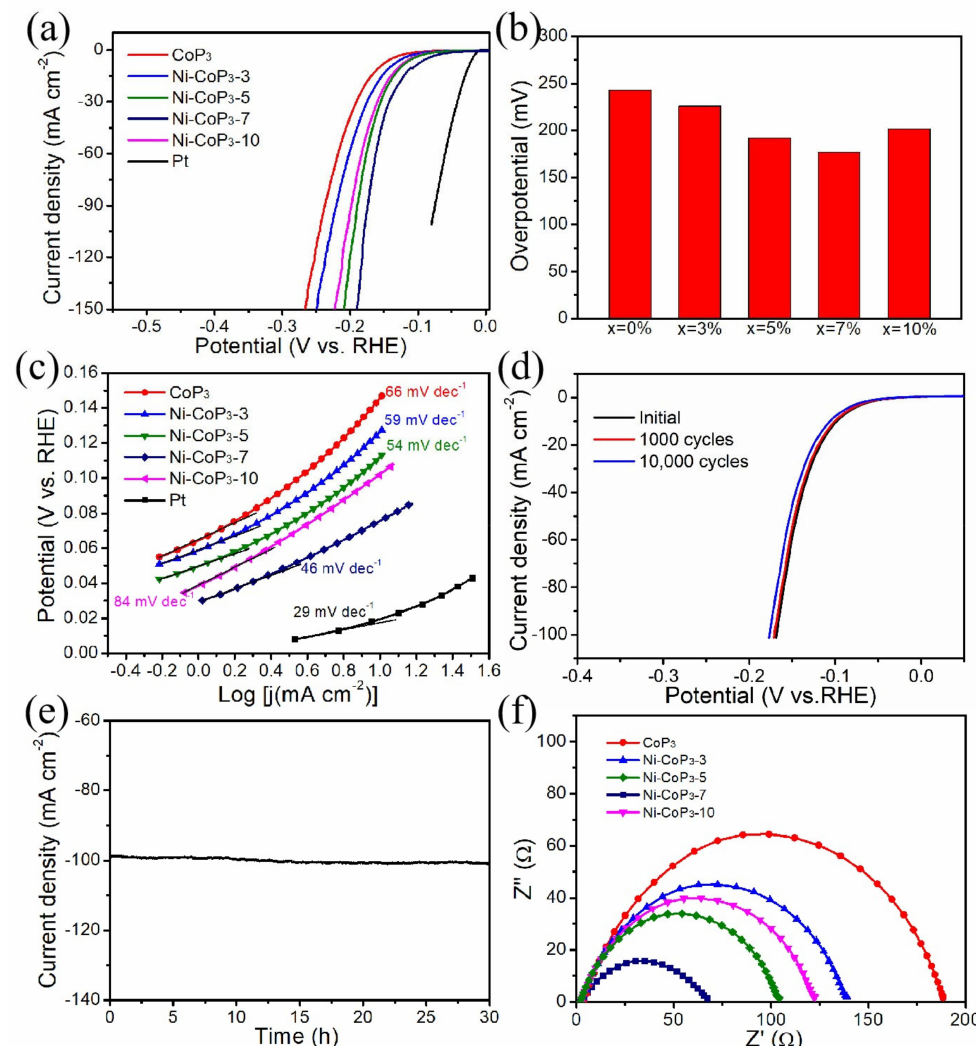
Figure 4. ( a ) HER performance of as-prepared Ni-CoP 3 NWAs/CC with different Ni concentrations and commercial Pt/C catalyst in 0.5 M H 2 SO 4 . ( b ) HER overpotentials for delivering current densities of 100 mA cm − 2 and ( c ) corresponding Tafel slopes for Ni-CoP 3 NWAs/CC with different Ni concentrations. ( d ) LSV curves of N-CoP 3 -7 before and after 10,000 cycles of cyclic-voltammetry scans. ( e ) Time dependence of current density for Ni-CoP 3 -7 at static overpotential of 172 mV for 30 h. ( f ) EIS for Ni-CoP 3 NWAs/CC with different Ni